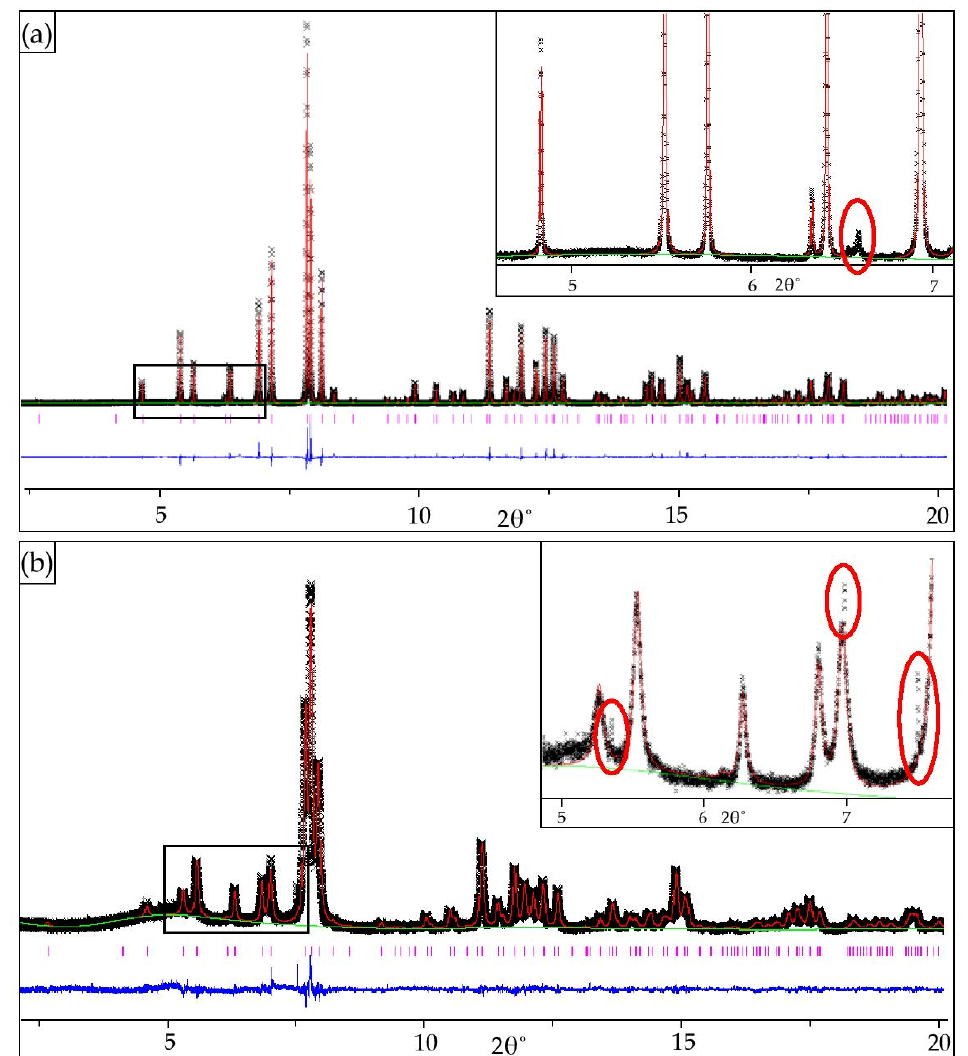
Figure 3. Final observed and calculated synchrotron X ‐ ray powder diffraction patterns for the Rietveld refinements of: ( a ) mimetite ‐ F and ( b ) mimetite ‐ I with insets displaying tiny peaks from unidentified contaminations (red circles).